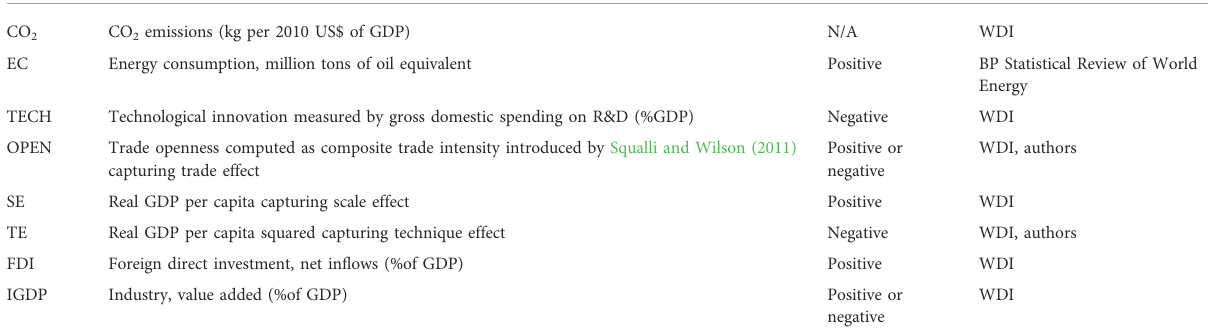
TABLE 2 De fi nition of variables and data sources.